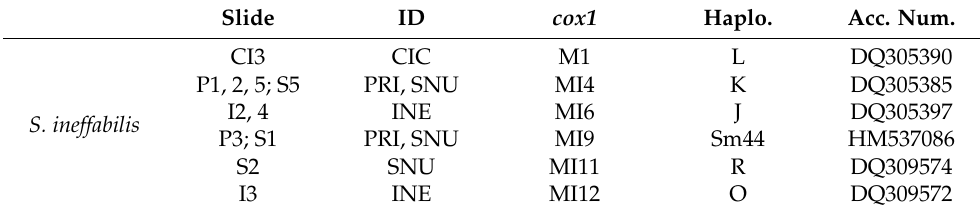
Table 7. S. ineffabilis specimens used for the haplotypic and morphological analyses (Slide) with cox1 haplotypes ( cox1 ) identical to previously published sequences of S. mollis (haplo.). Sampling localities with their ID codes where the specimens were found and accession numbers (Acc. num.) of the S. mollis haplotypes are also provided. Slide ID cox1 Haplo. Acc. Num.